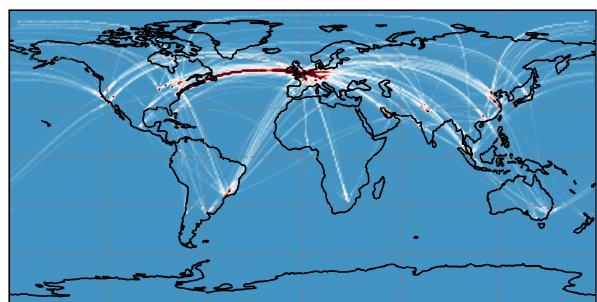
Figure 1. World map of H 2 O emission locations (white to red) by LAPCAT aircraft, summed over all vertical levels. A color bar is not included, because the motivation is to depict specifically the emis- sion location. Only one plot representative for all HIKARI emis- sion scenarios is shown, because hypersonic features of emission are dominant in the vertical sum, and ZEHST and LAPCAT scenar- ios show quite a similar horizontal distribution on the world map. A vertical distribution is shown in Fig.